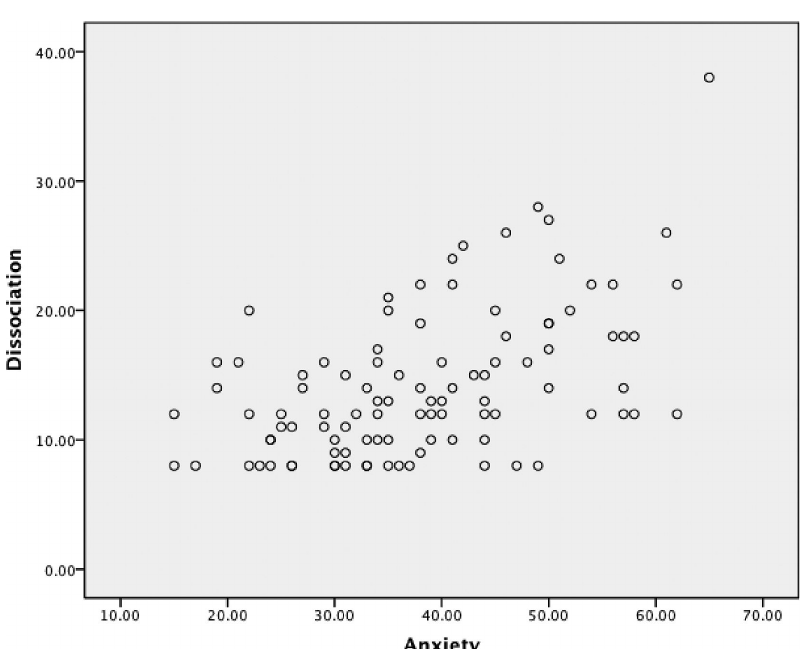
as absorption at one end to pathological states (such as having multiple identities) on the other [6].